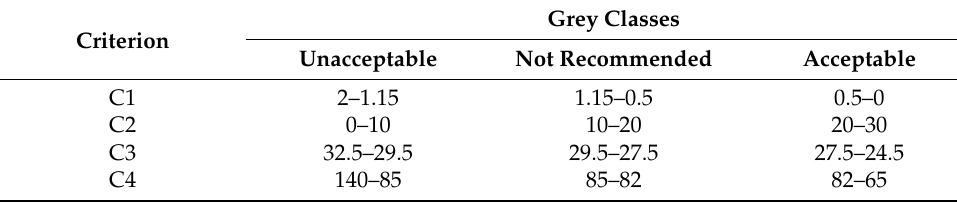
Table 4. Grey classes for each criterion in the case study.